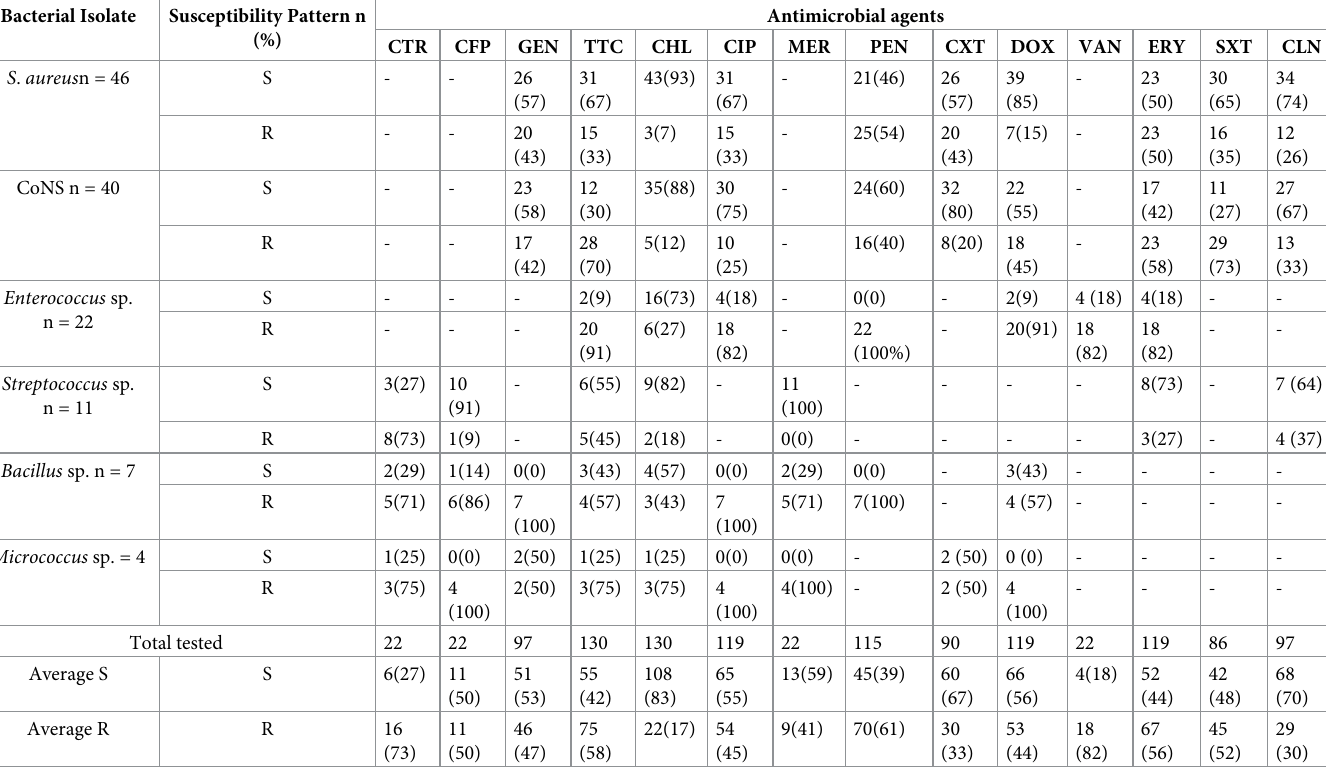
Table 4. Antibiotic susceptibility profiles of Gram-positive bacteria isolated from indoor air of selected wards of AMGH, February-April 2021. Bacterial Isolate Susceptibility Pattern n (%) S . aureus n = 46